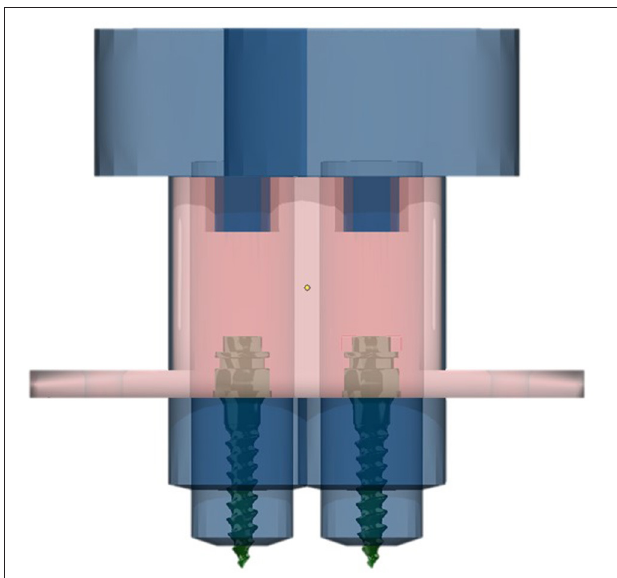
FIGURE 2 | CAD/CAM planning of the insertion guide using Onyxceph (Image Instruments, Chemnitz, Germany).